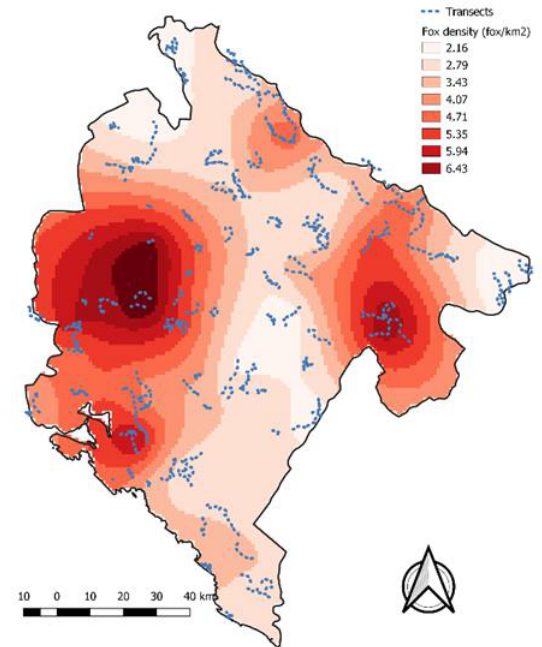
Figure 2. Fox density calculation through Ordinary Kriging interpolation and monitoring network.